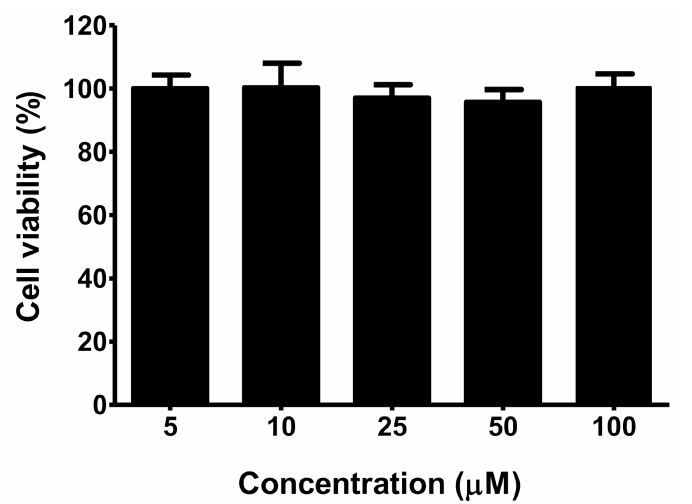
Figure 6. Cell viability of L929 cells as determined by an MTT assay after incubation with different concentrations of the dendron for 24 h. Data are expressed as means ± SD from four